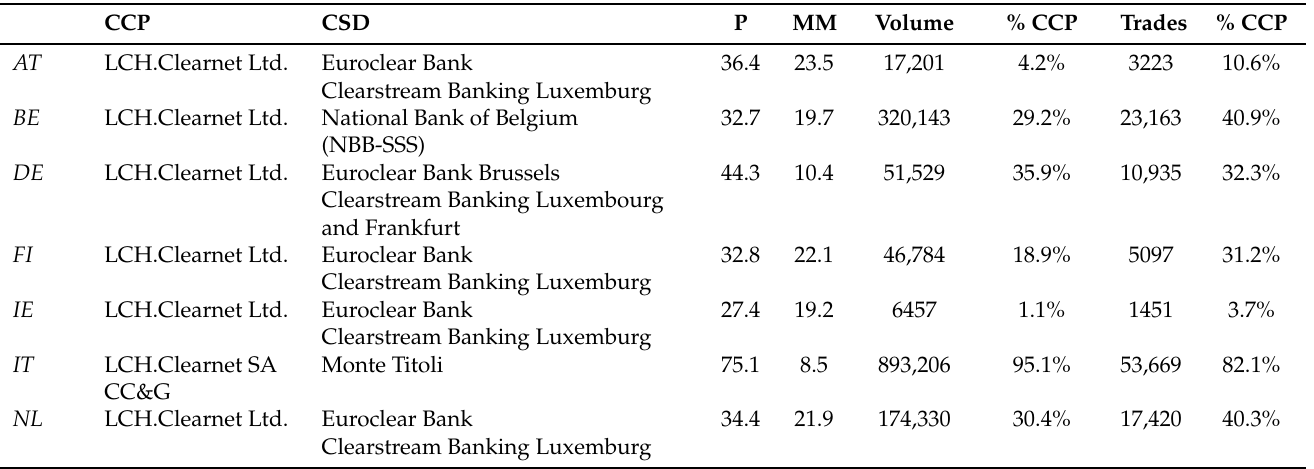
Table 1. Descriptive statistics of